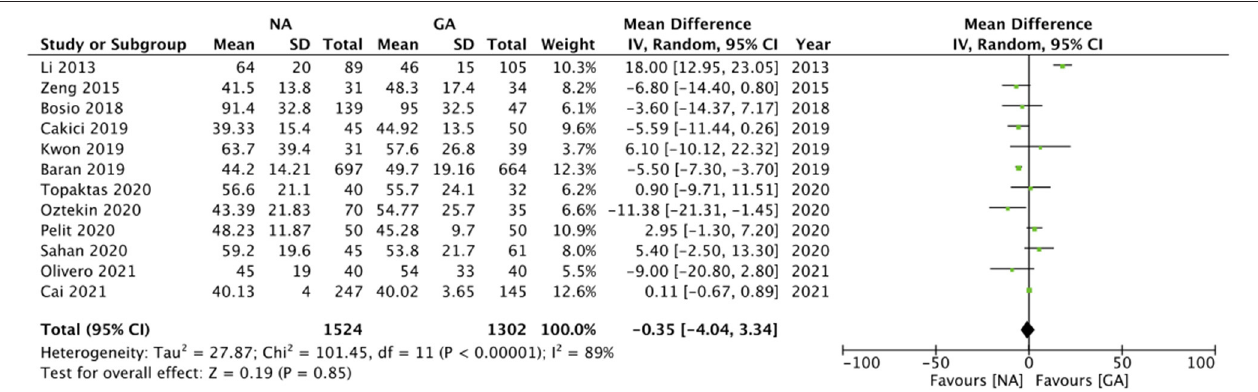
Frontiers in Surgery |